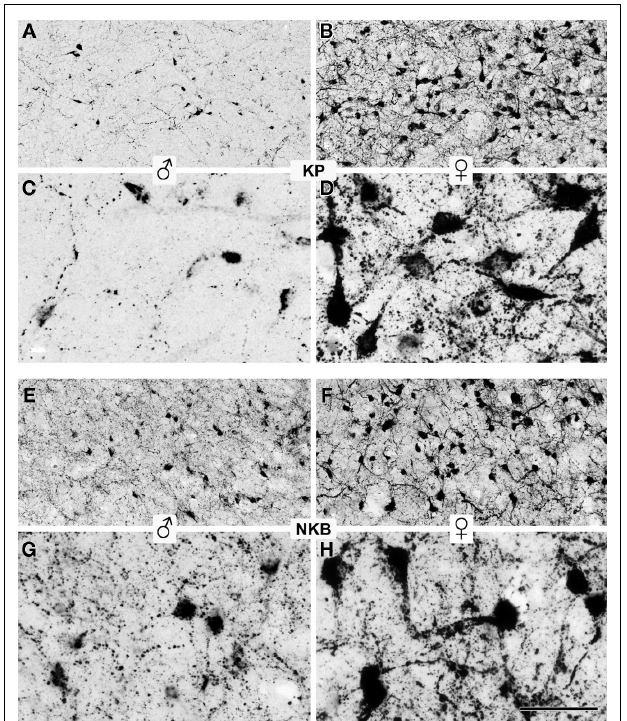
FIGURE 1 | Sexual dimorphism of kisspeptin-IR and preproNKB-IR neuronal elements in the Inf of aged human subjects. Kisspeptin (A–D) and preproNKB (E–H) immunoreactivities were visualized using the silver–gold-intensified Ni-DAB chromogen.The photomicrographs were taken from the Inf of 59-year-old male (A,C) and 62-year-old male (E,G) and 66-year-old (B,D,F,H) female individuals. Both kisspeptin-IR (D) and preproNKB-IR (H) cell bodies are larger in postmenopausal women compared with aged men ( C and G , respectively). Neuronal hypertrophy reflects lack of estrogen negative feedback in postmenopausal women. Kisspeptin neurons also show other robust sex differences in that the number of KP-IR cell bodies and the density of kisspeptin-IR fibers are much higher in aged women (B) compared with men (A) .The number of preproNKB-IR cell bodies is also higher in women (F) compared with men (E) , but the difference is less dramatic than in case of kisspeptin-IR cell bodies. No obvious sexual dimorphism exists in the regional density of NKB fibers (E–H) . For quantitative comparisons, see Figures 2 – 4 . Scale bar = 200 μ m in (A,B,E,F) and 50 μ m in (C,D,G,H) .